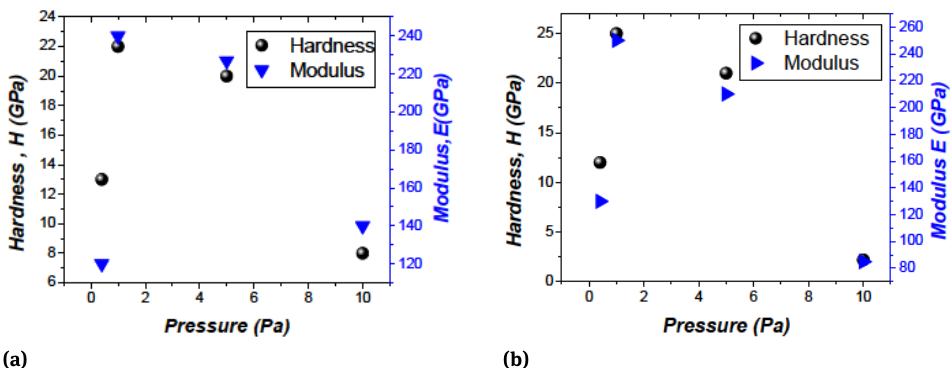
Figure 9: Variation of maximum average nanohardness and elastic modulus with pressure for Si-C-N coatings deposited on (a) Silicon and (b) Steel substrates.